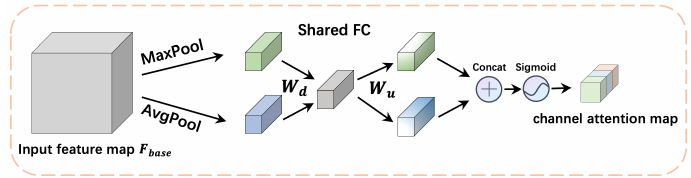
Figure 5. Diagram of channel attention extractor F ca () .